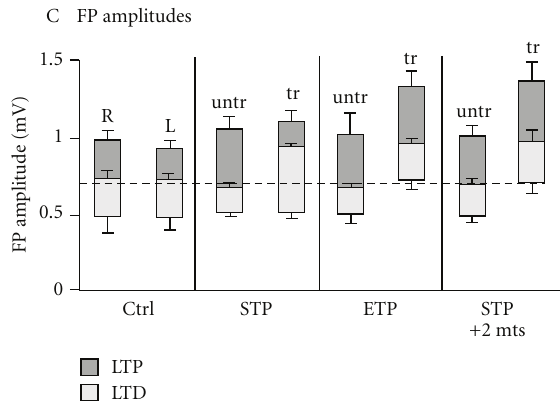
Figure 2: Taken from [10] with permission. Shown are the results from control animals (Ctrl), short task performance on the RGR task (STP, 3–6 days), extended task performance (ETP, 23–105 days) and short task performance followed by two months (STP + 2 mts). The trained (tr) hemisphere and the untrained (untr) hemisphere are shown for each group. The y -axis is the evoked field potential with LTP and LTD coded for by gray (LTP) or white (LTD). Note the change in the baseline and range after both the extended training as well as the short-task performance followed by two